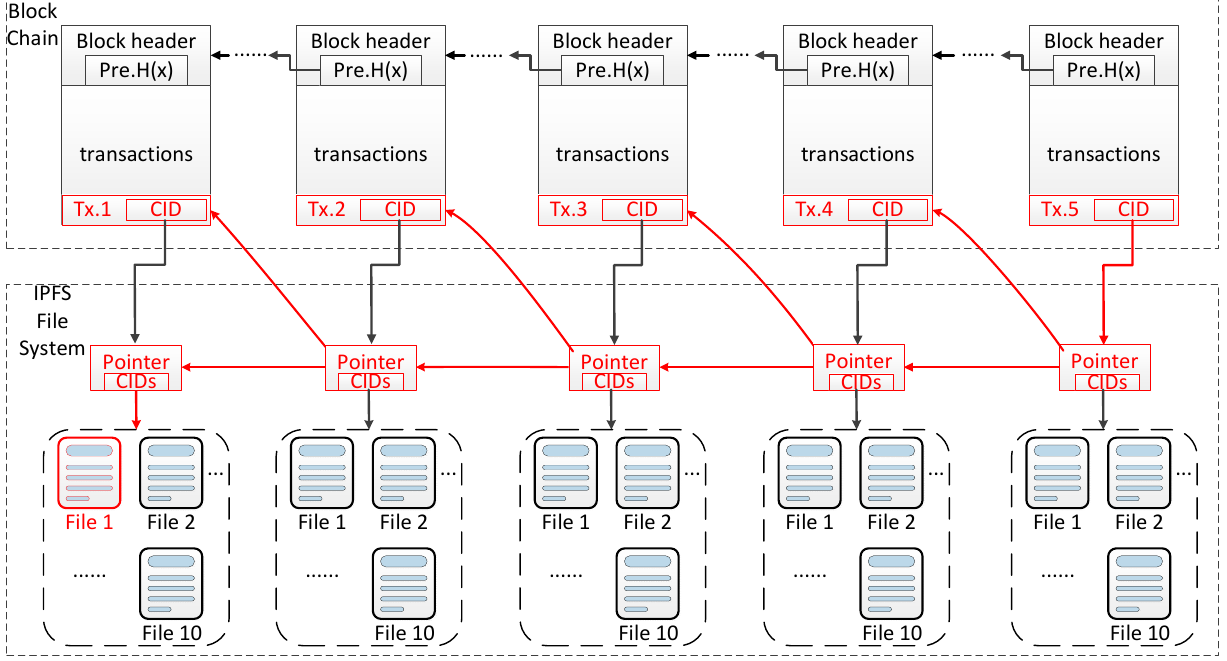
Figure 5. The interrelationship between transactions, pointers files, and evidence files in simulation.